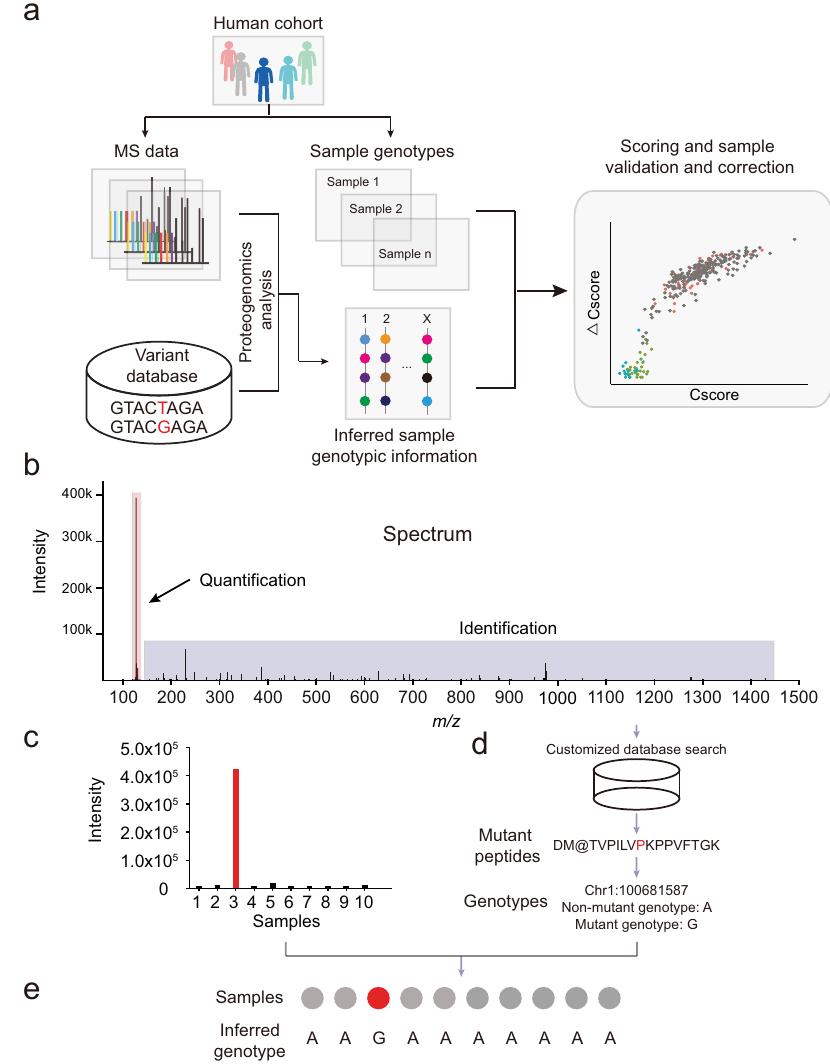
Fig. 1 Architecture of SMAP. ( a ) Schematic diagram of the SMAP pipeline. Mass spectrometry (MS)-based proteomic data are generated from a large- scale project. The data are searched against the customized database containing all theoretical variant peptides generated from whole-genome DNA sequencing, RNA sequencing, or public databases (e.g., dbSNP). For each batch of the TMT-based quantitative proteomic data, variant peptides are identi fi ed through proteogenomic analysis. Two scores (i.e., concordance score and delta concordance score) are computed for verifying and calibrating the sample identity. ( b ) Example of an MS spectrum containing TMT report ions. ( c ) A zoom-in view of the intensity of reporter ions is shown in panel b . ( d ) Identi fi cation of variant peptides using the proteogenomics approach. ( e ) Inferring sample genotypes from quantitative expression level of the variant peptide for each